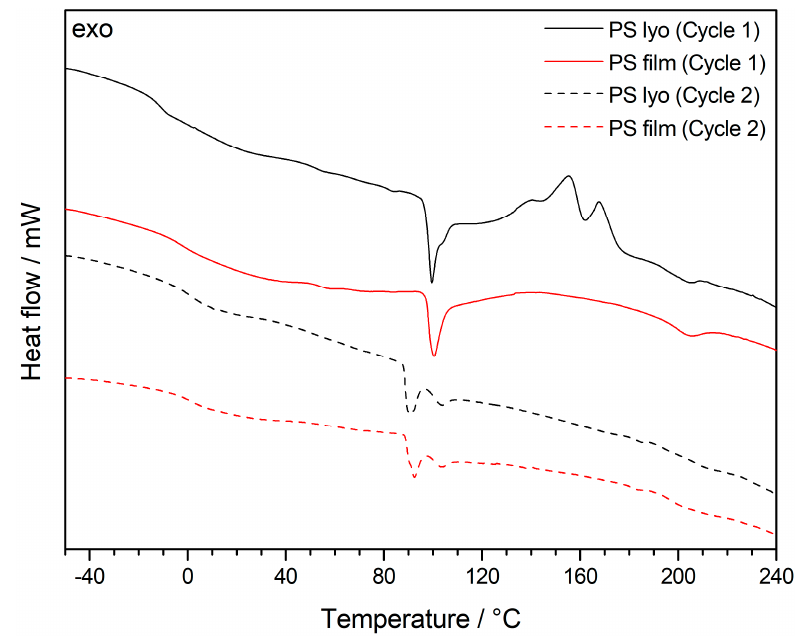
Figure 8. DSC thermograms of P(S- co -ALMA)@P(EA- co -MPSEt) lyophilized particle powder in comparison with the hybrid particle film after melt-shear organization. DSC measurements were performed with a heating rate of 5 K min − 1 in nitrogen atmosphere.